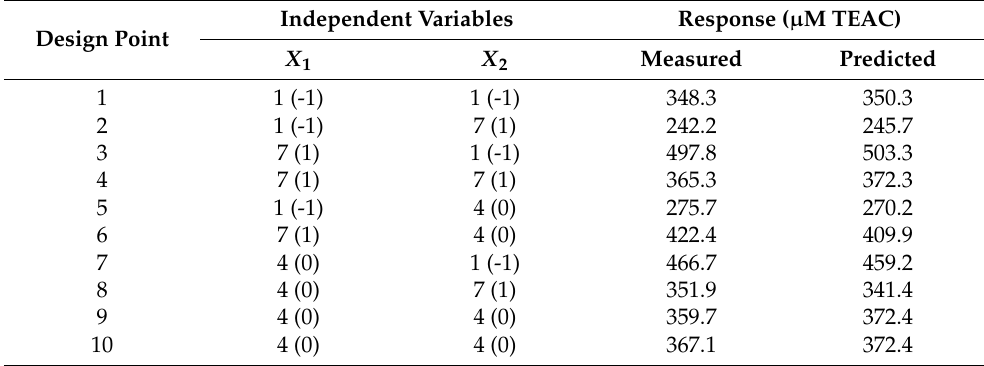
Table 1. Measured and predicted TEAC values of α -T/ δ -T mixtures, determined for individual design